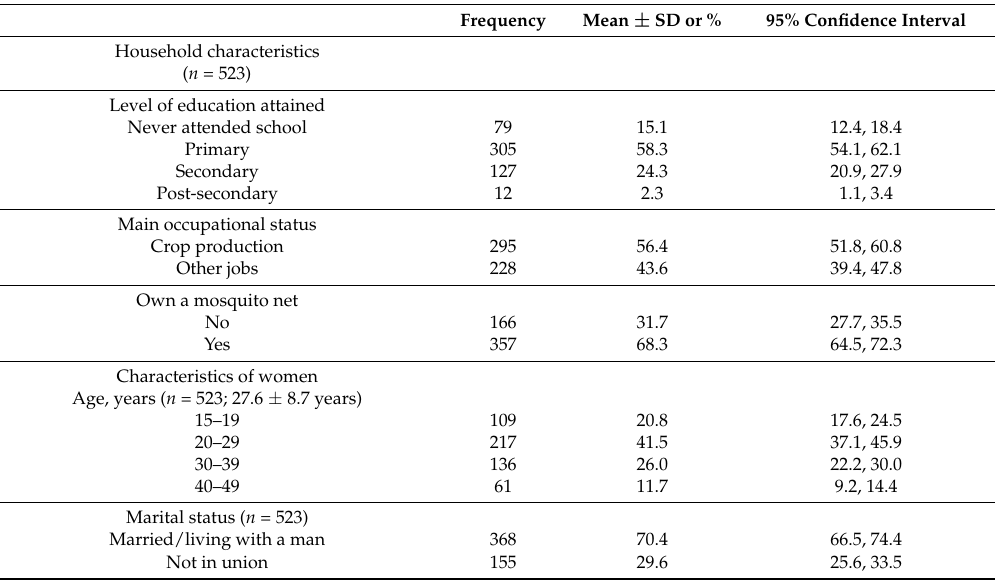
Table 1. Household characteristics and nutritional status of women of child-bearing age in rural Zambia.